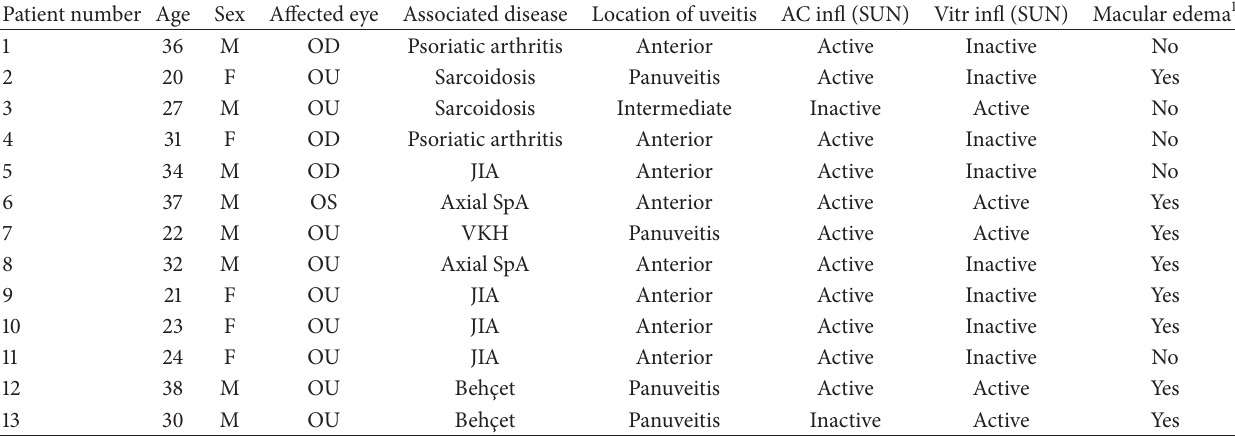
Table 1: Demographic and diagnostic information of all included patients.